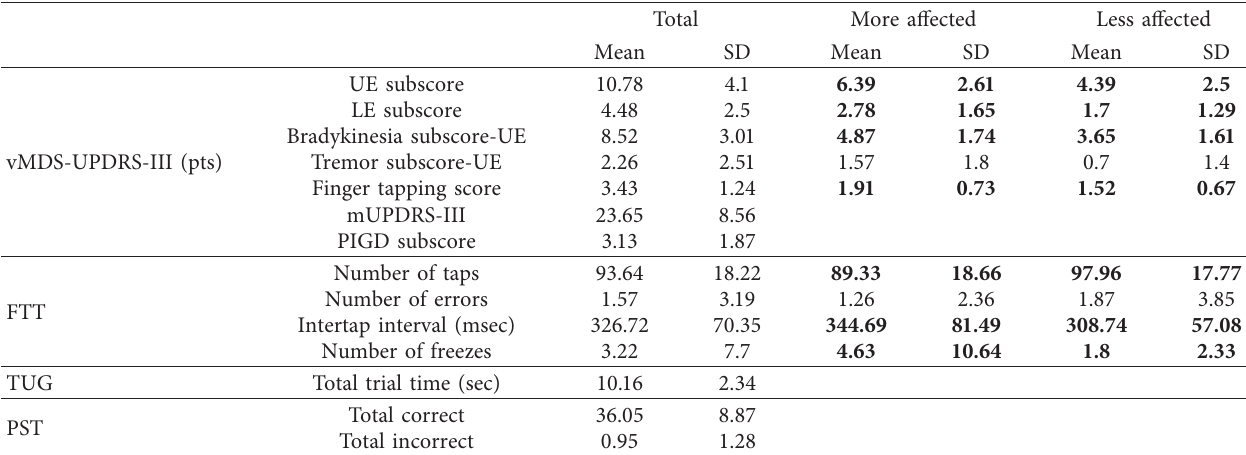
Total trial time (sec) ∗ p < 0 . 05;boldvaluesindicate a significant difference between more and less affected sides. FTT, FingerTapping Test; LE, lower extremity, PST, ProcessingSpeed Test; UE, upper extremity; TUG, timed up and go test; and virtual Movement Disorder Society-Unified Parkinson’s Disease Rating Scale III (vMDS-UPDRS